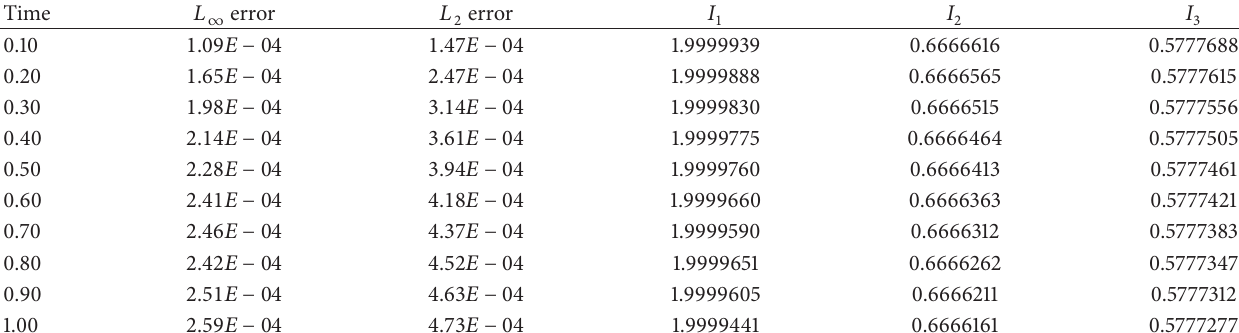
Table 2: Numerical errors and invariants with 𝑁 = 100 at different times.